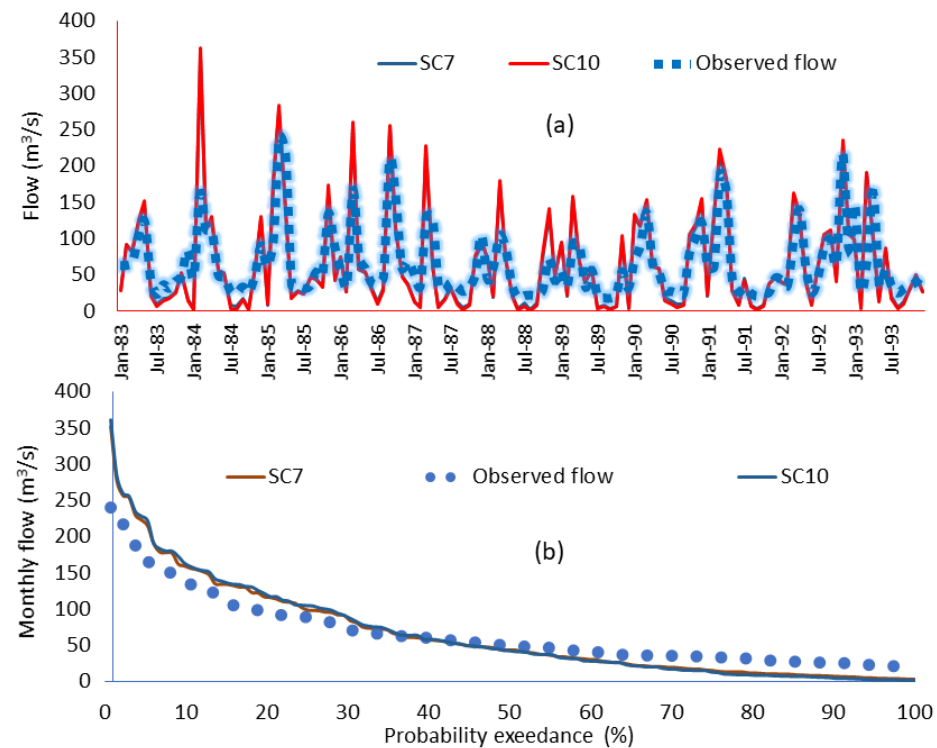
Figure 8. Comparison of simulated temporal streamflow scenarios (SC1 and SC4) with observed data at Ingresol station (T1). ( a ) Monthly time series plot for the time period of 1983 to 1993. ( b ) Flow duration curve (FDC) at station T1.